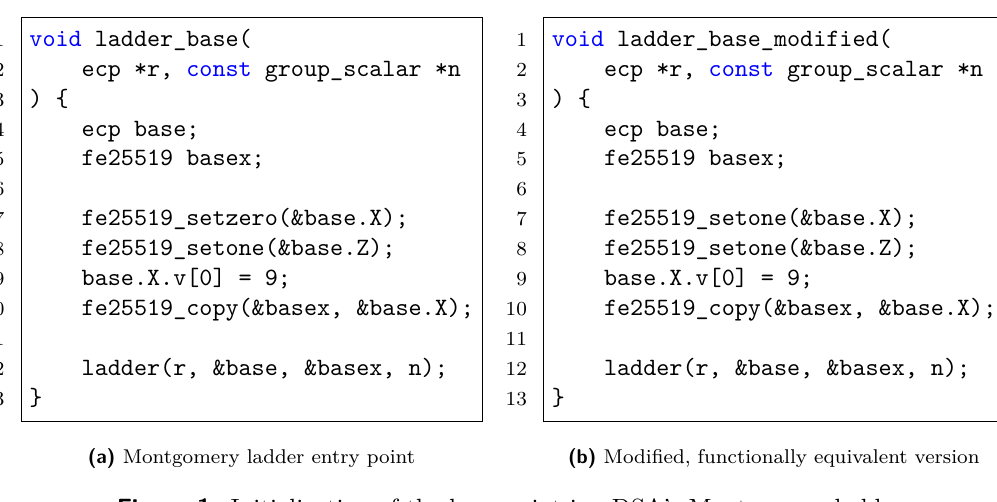
Figure 1: Initialization of the base point in qDSA’s Montgomery